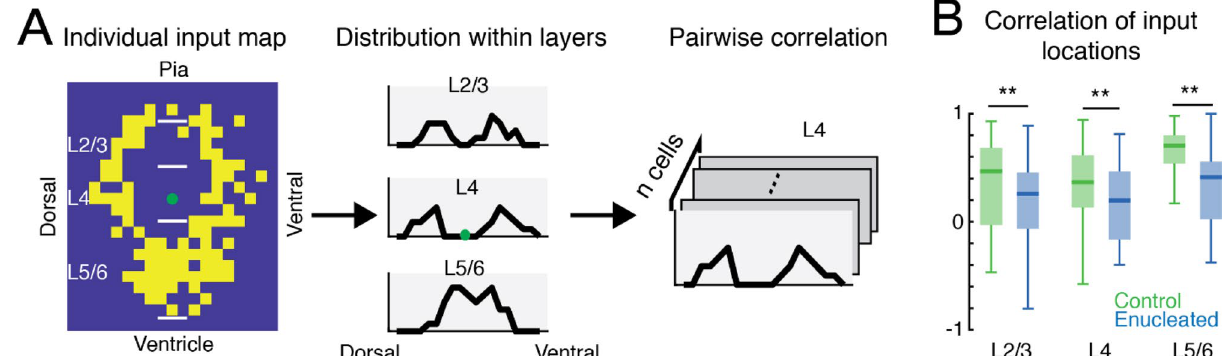
Figure 3. Decreased variability of the input locations between cells after enucleation. ( A ) Quantification of the variability of the input locations. The distribution profiles of input from each layer group are calculated from input location maps. Pairwise correlation is calculated from the distribution profiles from different cells to quantify the variability of the input locations. ( B ) Boxplot of the correlation of input locations originating from each layer. (**) indicates P < 0.01, otherwise P > 0.05. Statistics for ( B ) are in Table